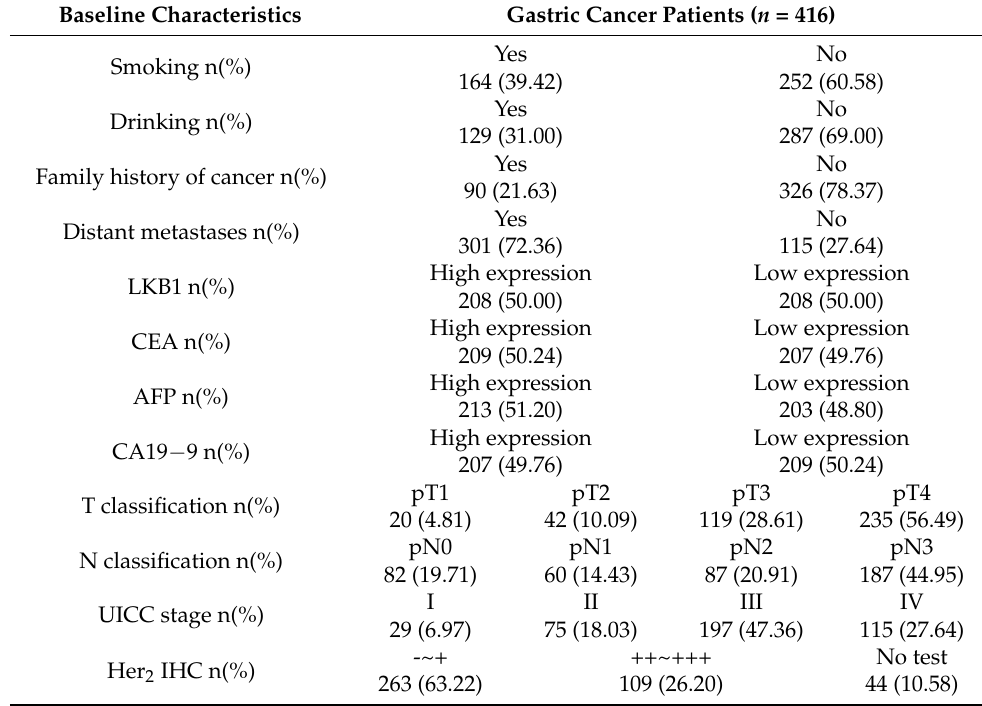
Table 2. Baseline characteristics of GC